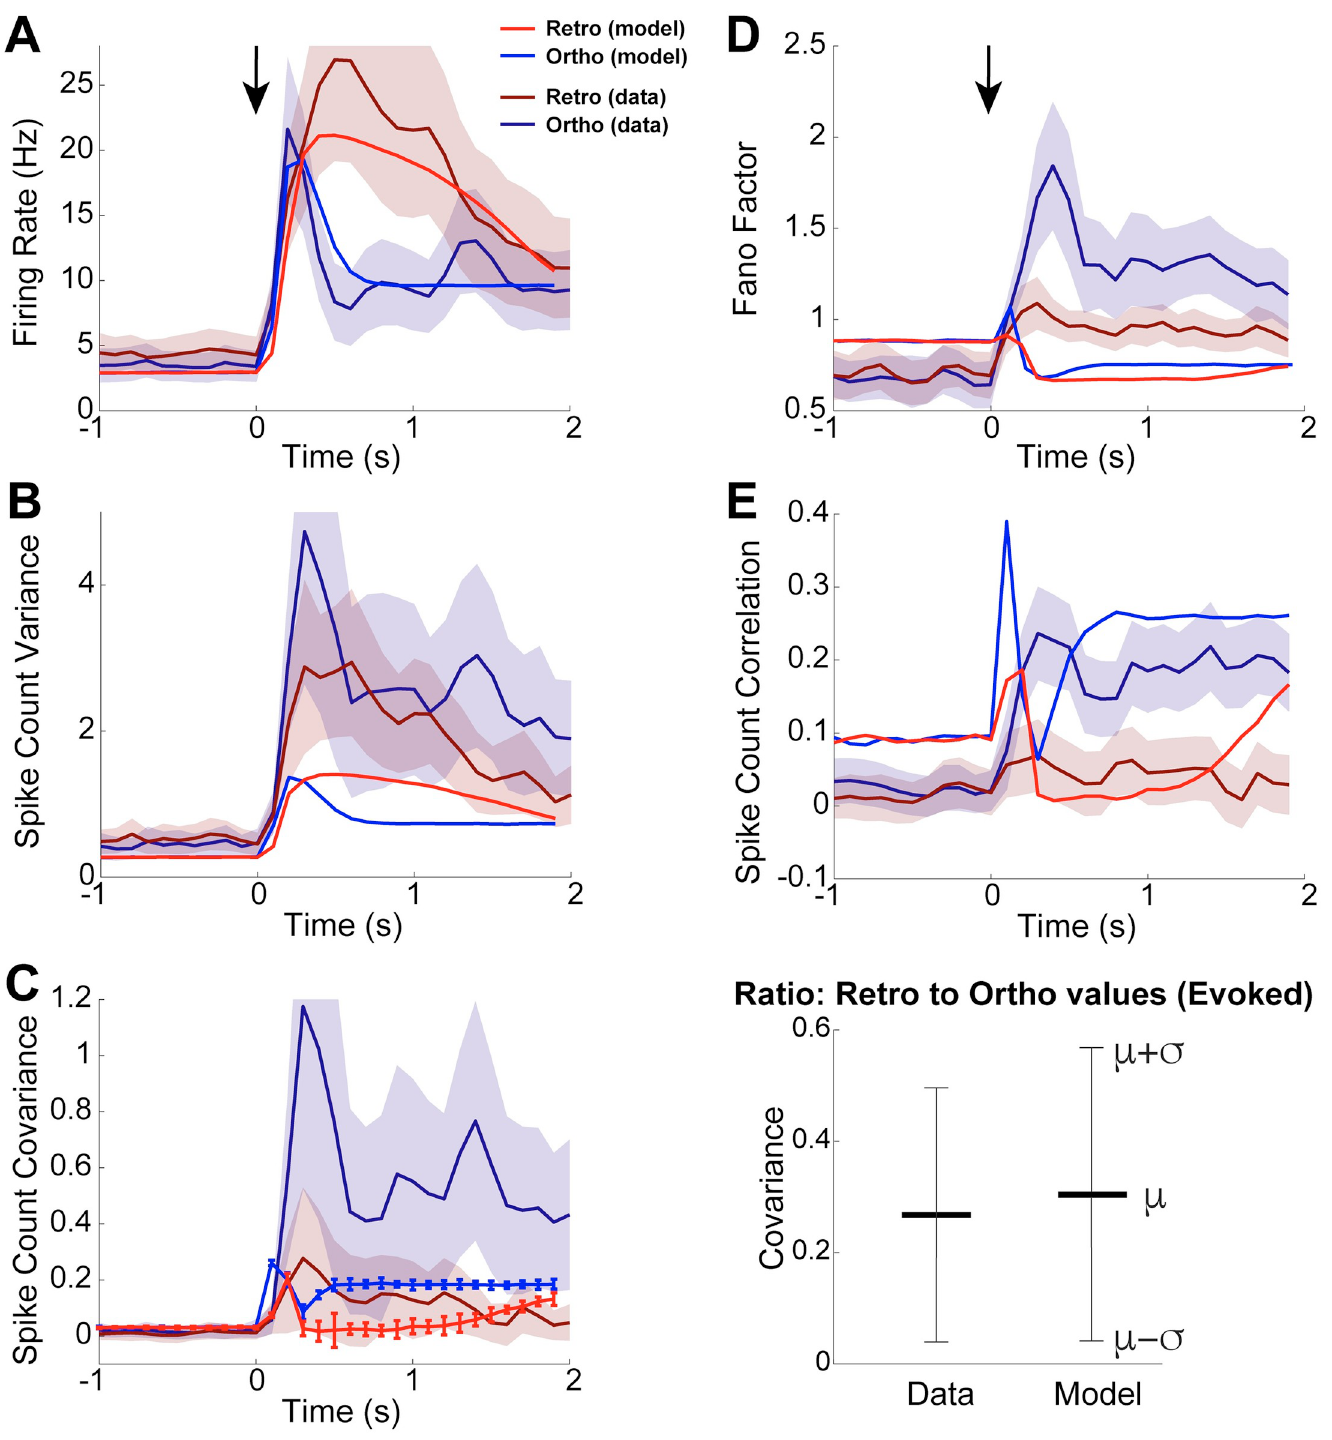
Fig 3. OB model captures trends in our data. Comparison of all first and second-order statistics of coupled OB network model to our data. A) Firing rate of ortho increases and decays faster than retro in both data and model. B) Variance of spike counts for ortho and retro shown for completeness, but recall that in experimental data that they are not statistically different. C) Covariance of spike counts is larger for ortho than retro in both data and model (left), but the magnitudes of data and model differ. Comparison of the ratio of retro covariance to ortho covariance in the evoked state (right) shows that the model captures the relative differences between ortho and retro—here μ (resp. σ ) is the average (resp. standard deviation) ratio over 20 time bins in the evoked state. For A–C , top shaded error regions of data (retro in A , ortho in B,C ) are cut-off to better compare model and data. Comparisons of the ( D ) Fano factor and ( E ) Pearson’s spike count correlation shown for